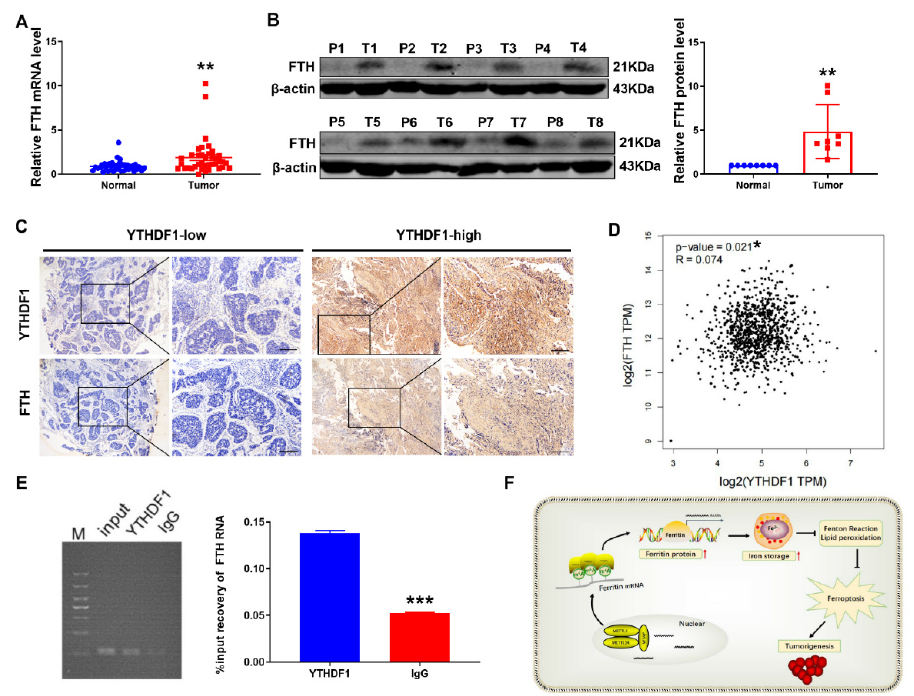
Figure 7. The expression of FTH is upregulated and positively correlated with YTHDF1 in lung cancer. ( A , B ) qRT-PCR and Western blot analysis of FTH mRNA expression and protein level in lung cancer tissues and adjacent normal tissues. ( C ) Representative immunohistochemical images of YTHDF1 and FTH in the lung cancer tissues. Scale bar, 50 µ m. ( D ) FTH was shown to be markedly and negatively associated with YTHDF1 in the GEPIA database. ( E ) RIP was conducted to confirm the FTH mRNA enrichment by YTHDF1 in lung cancer tissues. ( F ) Schematic diagram indicating that YTHDF1 mediated ferritin in regulation of lung cancer carcinogenesis. ** p < 0.01 and *** p <